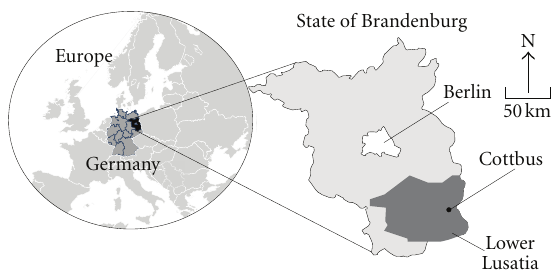
Figure 1: Location map of the lignite mining region of Lower Lusatia in NE